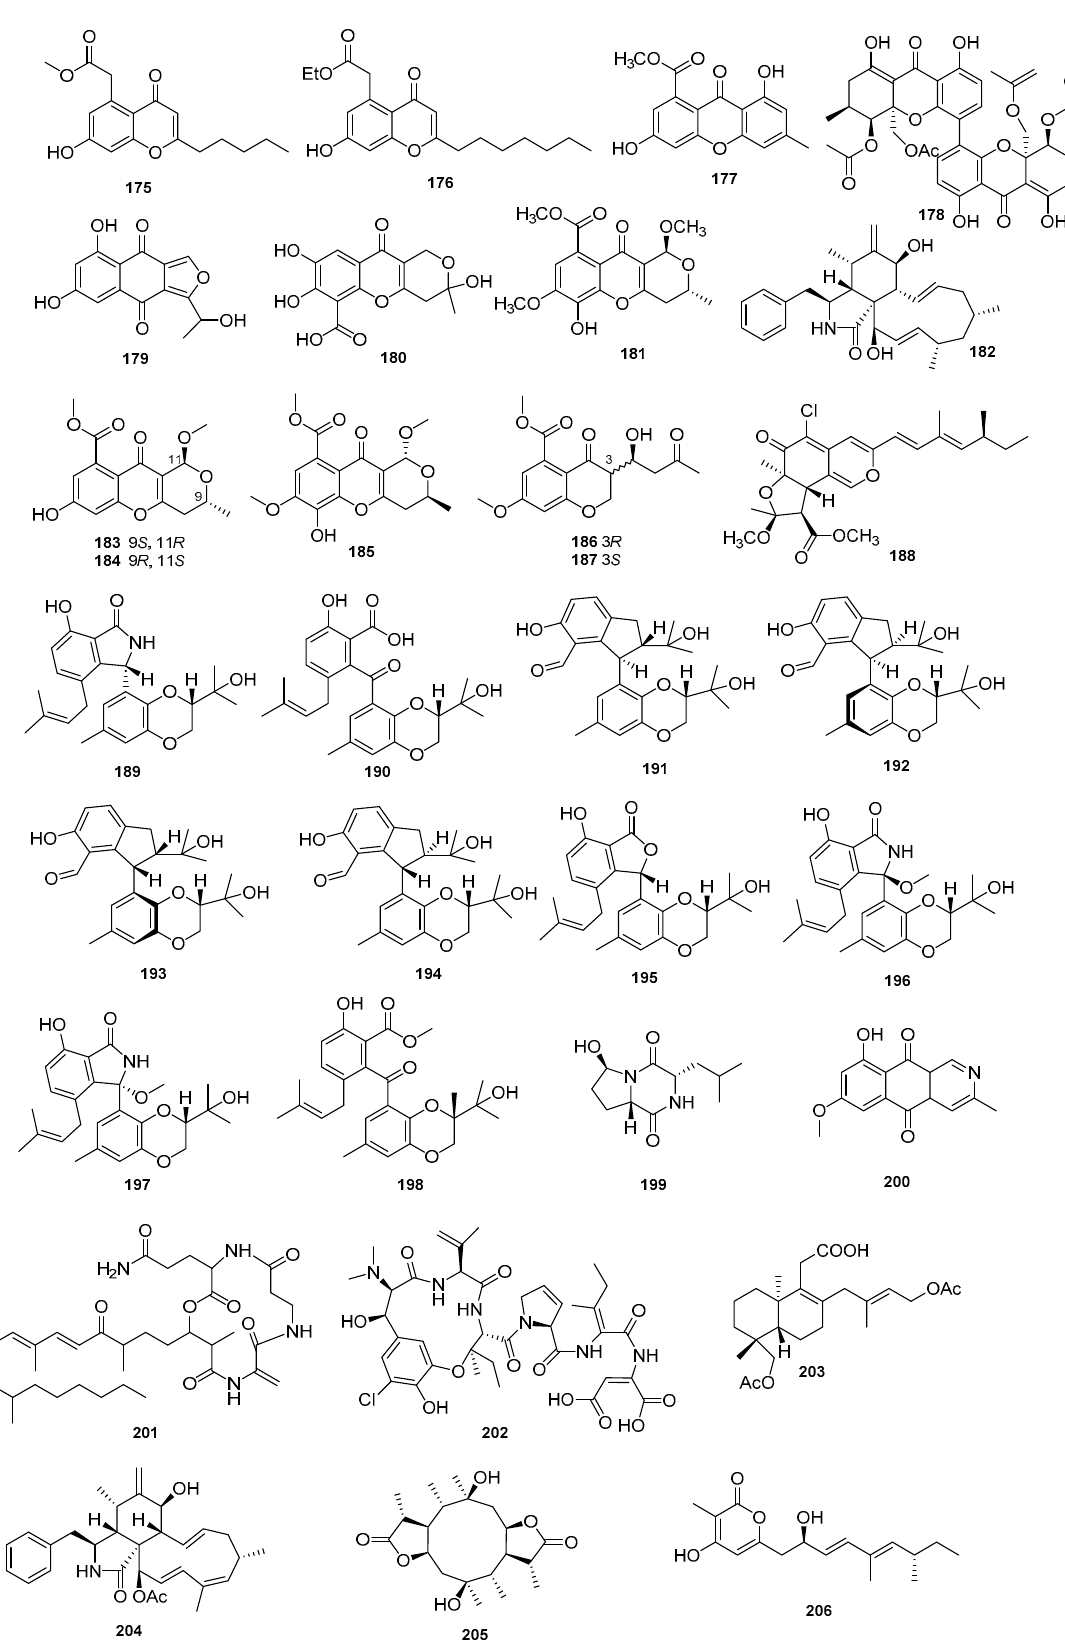
Figure 7. Chemical structures of compounds 175 – 206 of marine origin.